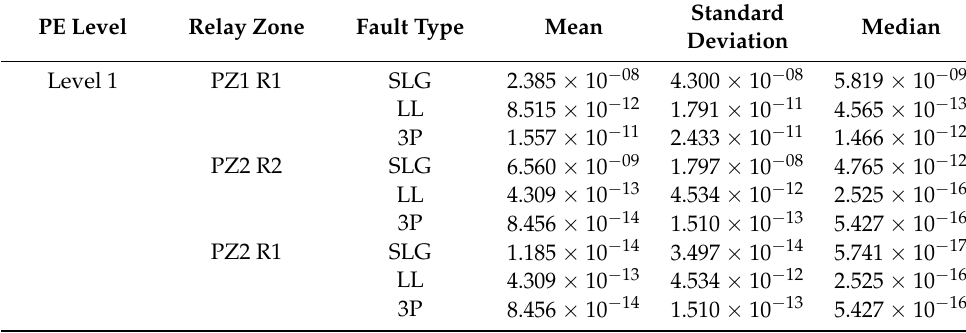
Table A5. PE values ground